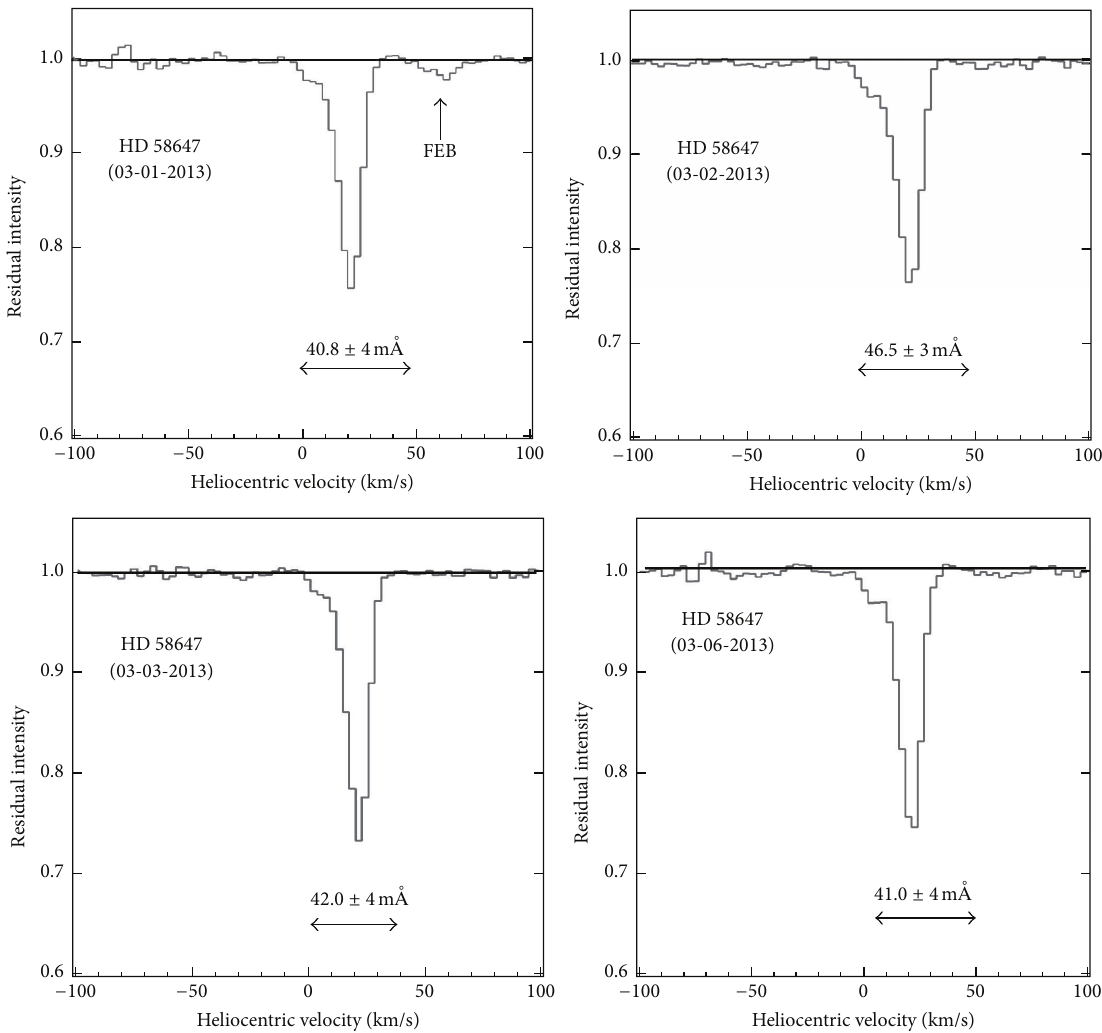
Figure 3: The circumstellar CaII K-line absorption spectra of HD 58647 recorded on 4 nights in March 2013. An FEB absorption event at 𝑉 ∼ +65 km s −1 that is present on 03-01-2013 moves to blue wavelengths by the following night which accounts for the increase in the equivalent width of the central absorption on 03-02-2013. This “extra” absorption disappears in the spectra recorded on the following nights.